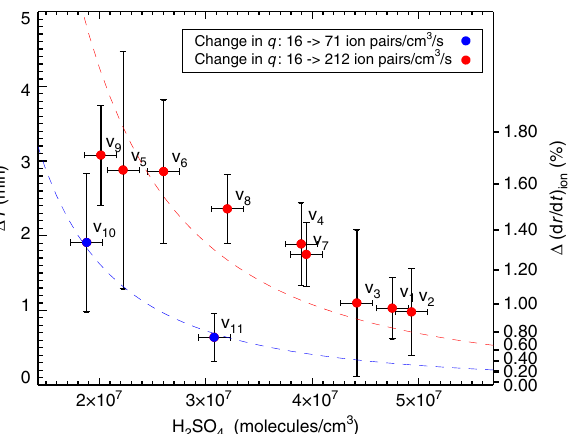
d i Fig. 5 Interaction coef fi cients. The interaction coef fi cients between a small neutral particle of mass 100 AMU and a small ion of mass 225 AMU interacting with aerosols of diameter d . The interaction between neutral particles, β 00 , is given by the blue curve, the interaction between small neutral particles and charged aerosols, β 0 ± , is given by the red curve. The interaction between a positive or negative ion and neutral aerosols, β ± 0 , is described with the yellow curve. Finally, the recombination coef fi cient between two oppositely charged particles is given by the brown curve. The coef fi cients were calculated assuming Brownian diffusion while including Van der Waals-forces, Coulomb-forces (including image charges) and viscous forces 24 . Symmetry between positive and negative ions has been assumed, see